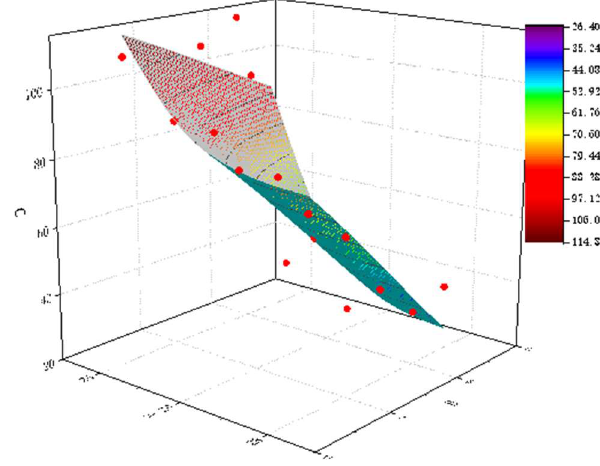
Figure 12. Three-dimensionaldata fitting surface figure.